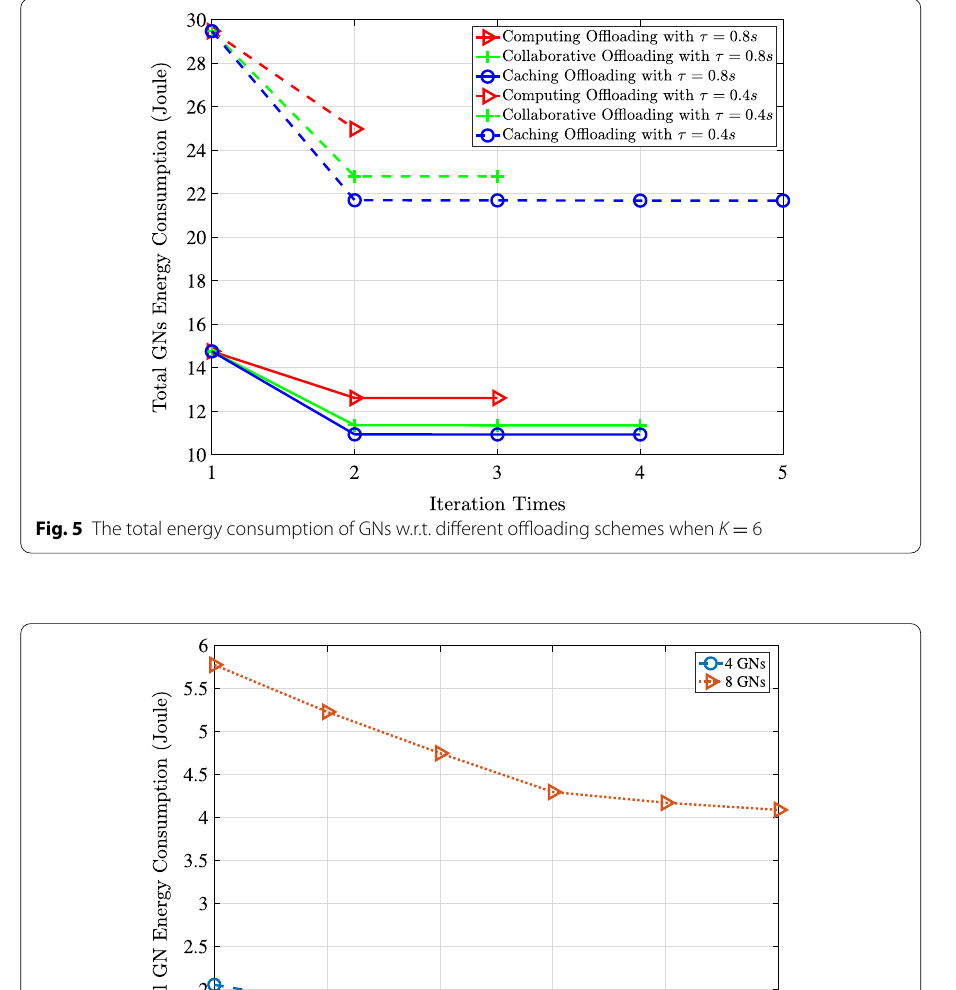
Fig. 6 The total energy consumption of different numbers of GNs w.r.t. different QoE requirement of time‑sensitive